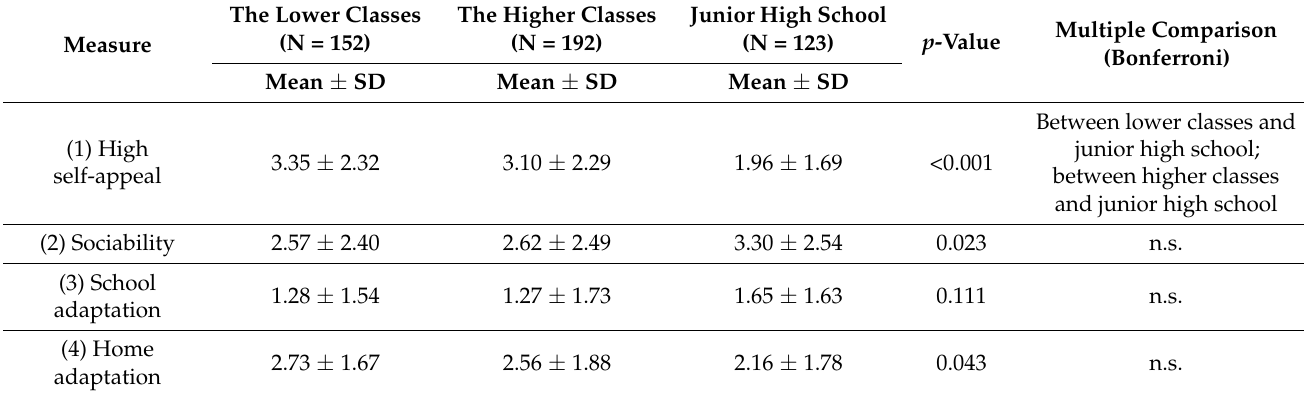
Table 1. The mean and standard deviation for measures: one-way analysis (N = 467).